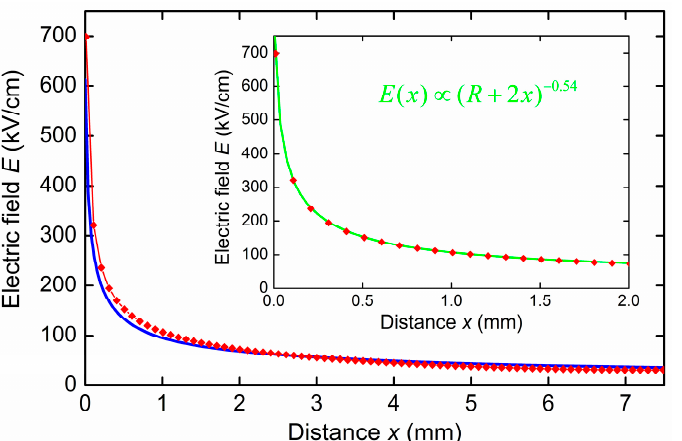
Figure 3. Field distributions in the gap for model (blue solid line) and real (red diamonds) geometries. The inset shows the calculated field distribution near the edge of the real cathode (red diamonds) and its power-law approximation with exponent β = 0.54 (green solid line).